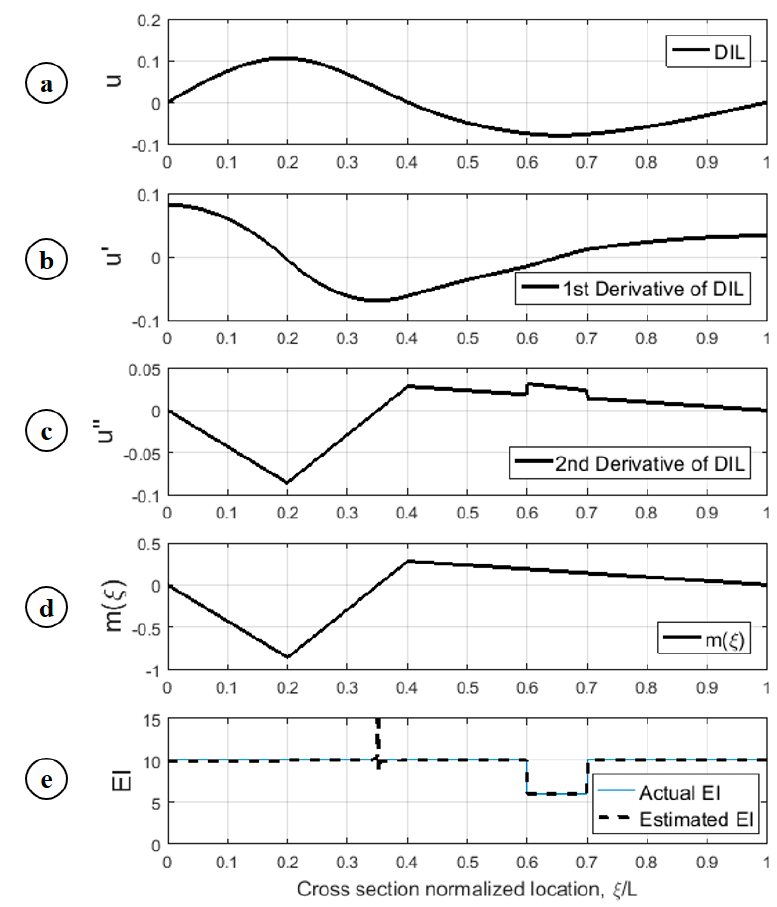
Figure 6. Example-2 Analysis results ( a ) recorded DIL; ( b ) first derivative of DIL; ( c ) second derivative of DIL; ( d ) diagram of moment m ( ξ ) ; and, ( e ) beam flexural rigidity estimation